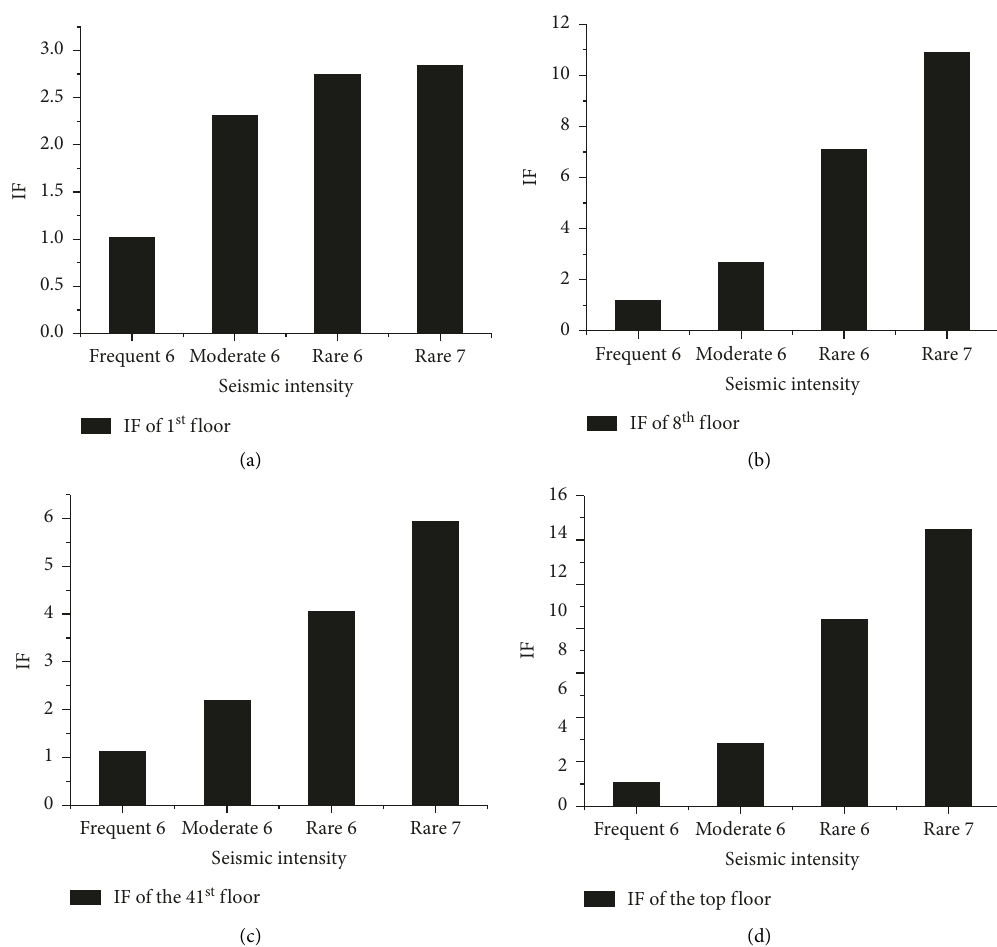
Figure 12: IF of some floors after different earthquake intensities: (a) 1 st floor; (b) 8 th floor; (c) 41 st floor; (d) top floor.